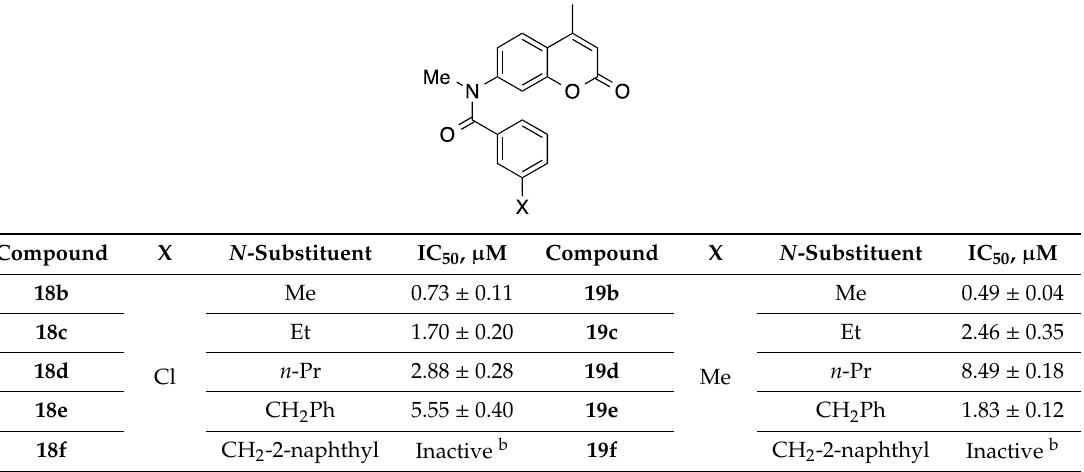
Table 2. Effect of N -substituents of coumarinamide derivatives on AR-antagonistic activity in SC-3 cell assay a .